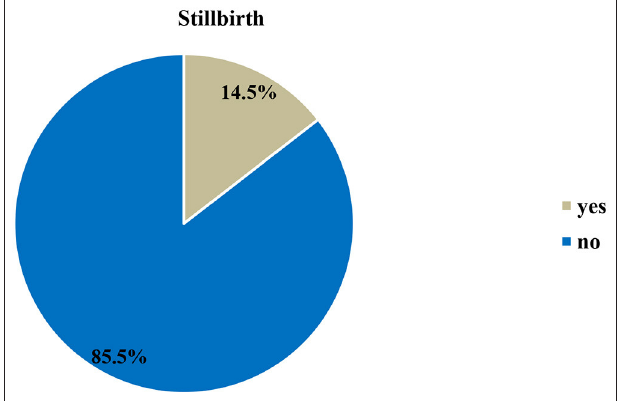
FIGURE 1 | Prevalence of stillbirth at Hiwot Fana Specialized University Hospital, Harar, Eastern Ethiopia, 2018/2019 ( n = 557).